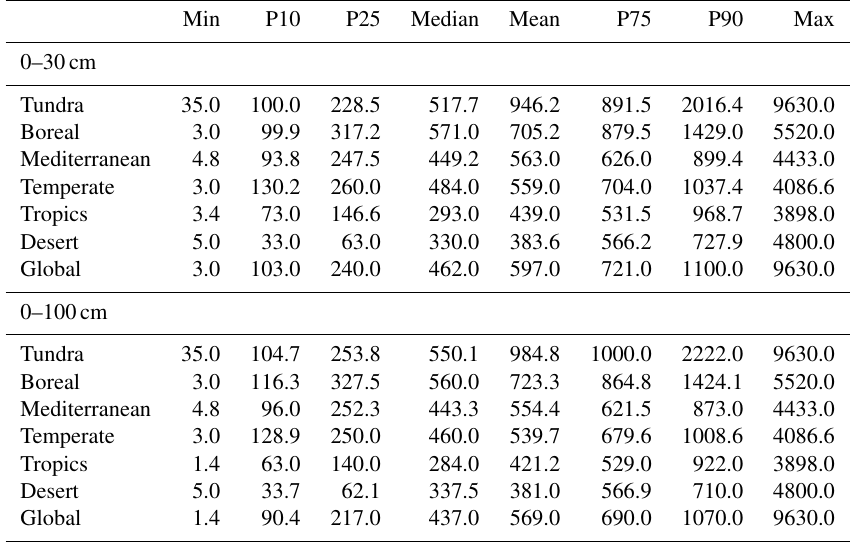
Table 2. Soil total P concentration (mgkg − 1 ) in natural ecosystems for major biomes at 0–30 and 0–100cm depth. Results are based on our site-level database. P10, P25, P75, and P90 indicate the percentile ranks of 10%, 25%, 75%, and